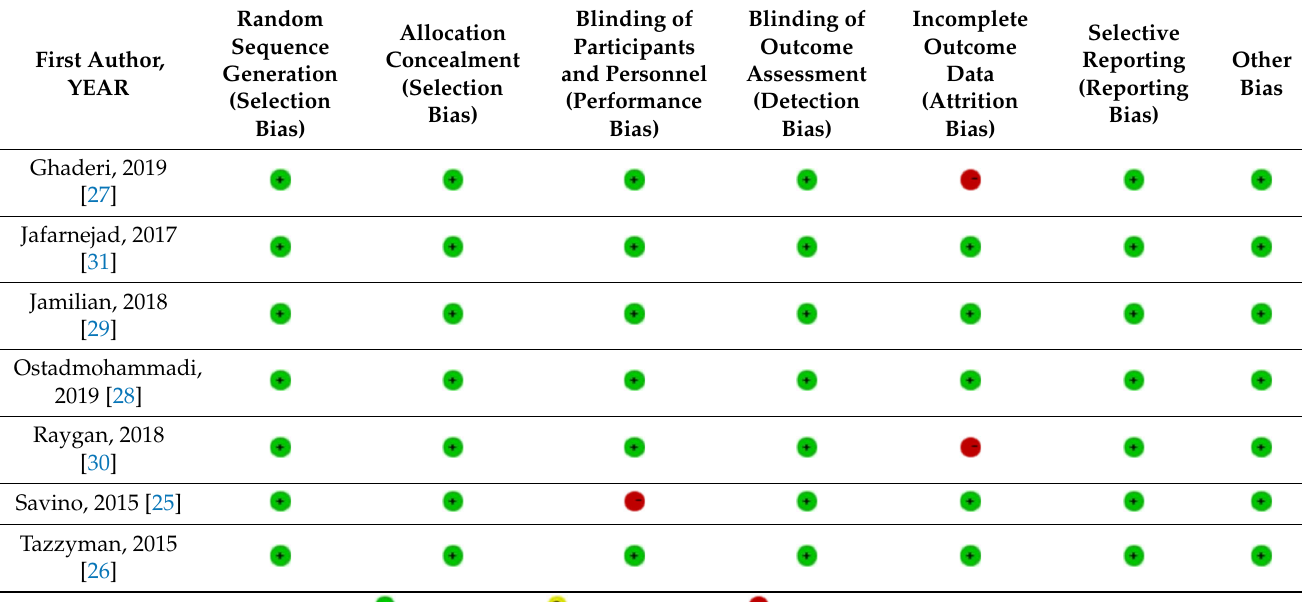
Table 2. Risk of bias of included studies from consensus between a pair of